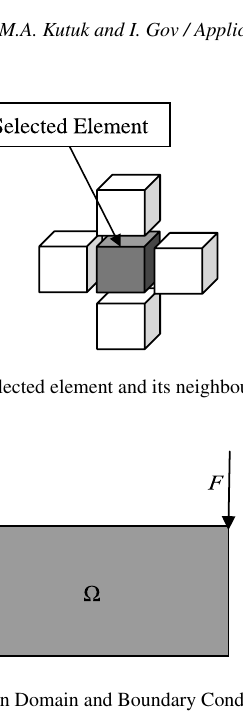
Fig. 3. Design Domain and Boundary Conditions.